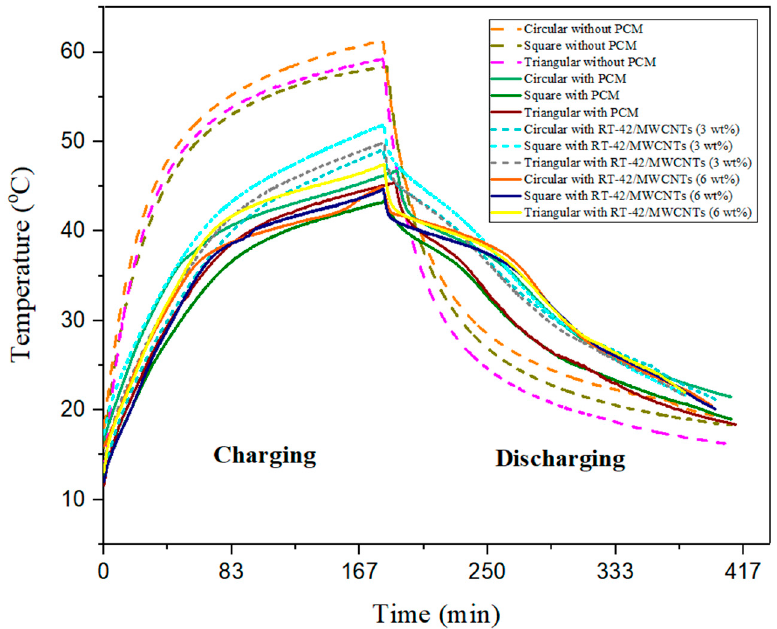
Figure 11. Comparison of different configurations for base temperature reduction without PCM, with PCM and NePCM (3 wt%, 6 wt%).